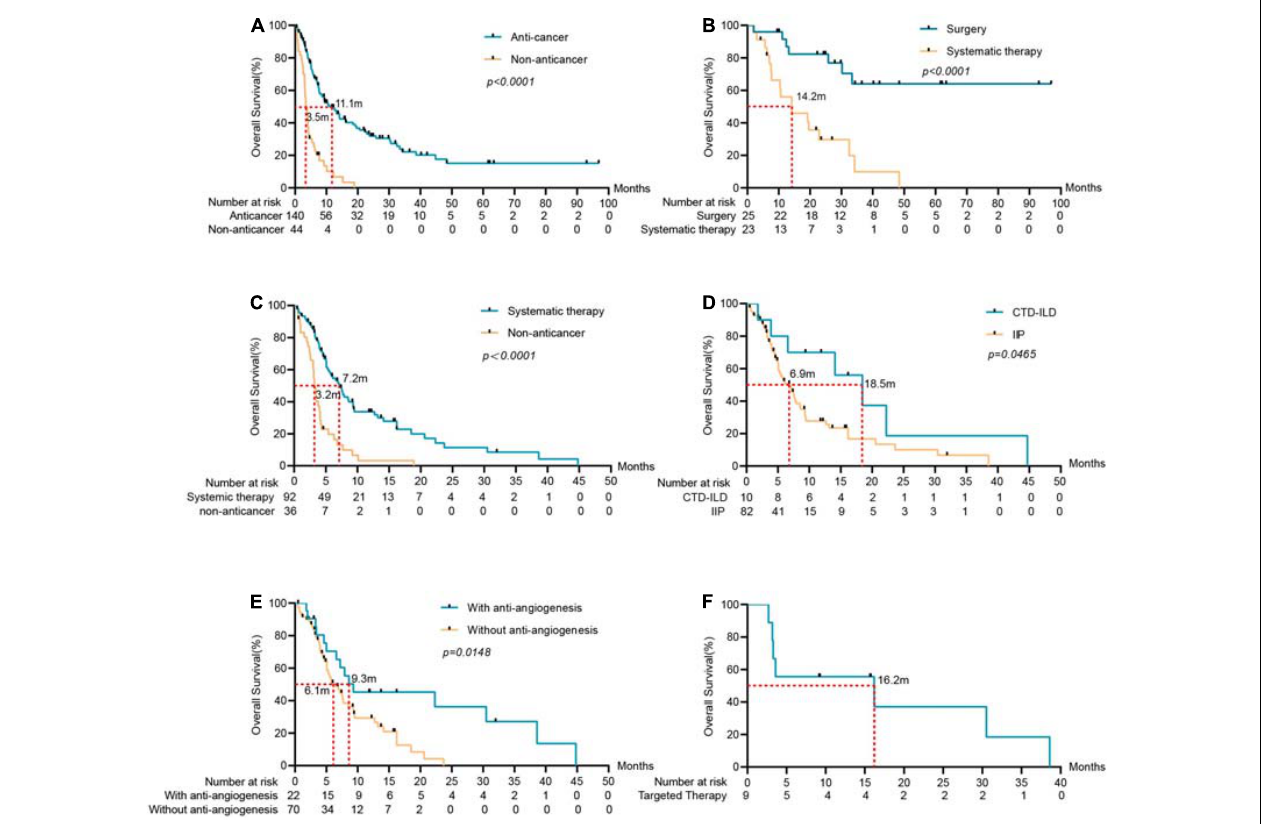
FIGURE 2 | Survival analysis of ILD-LC patients in different groups. (A) Anti-cancer group ( n = 140) vs. non-anticancer group ( n = 44), the mOS of the anti-cancer group was significantly longer than that of the non-anticancer group. (B) Surgery group ( n = 25) and systematic therapy group ( n = 23) in early-stage LC with ILD. (C) Systematic therapy group ( n = 92) vs. non-anticancer group in advanced stage LC with ILD. (D) For patients in advanced stage LC with ILD, OS was associated with the subtype of ILD ( p = 0.0465). (E) OS was associated with anti-angiogenesis ( p = 0.0148). (F) Patients received targeted therapy in advanced stage LC with ILD and the mOS was 16.2